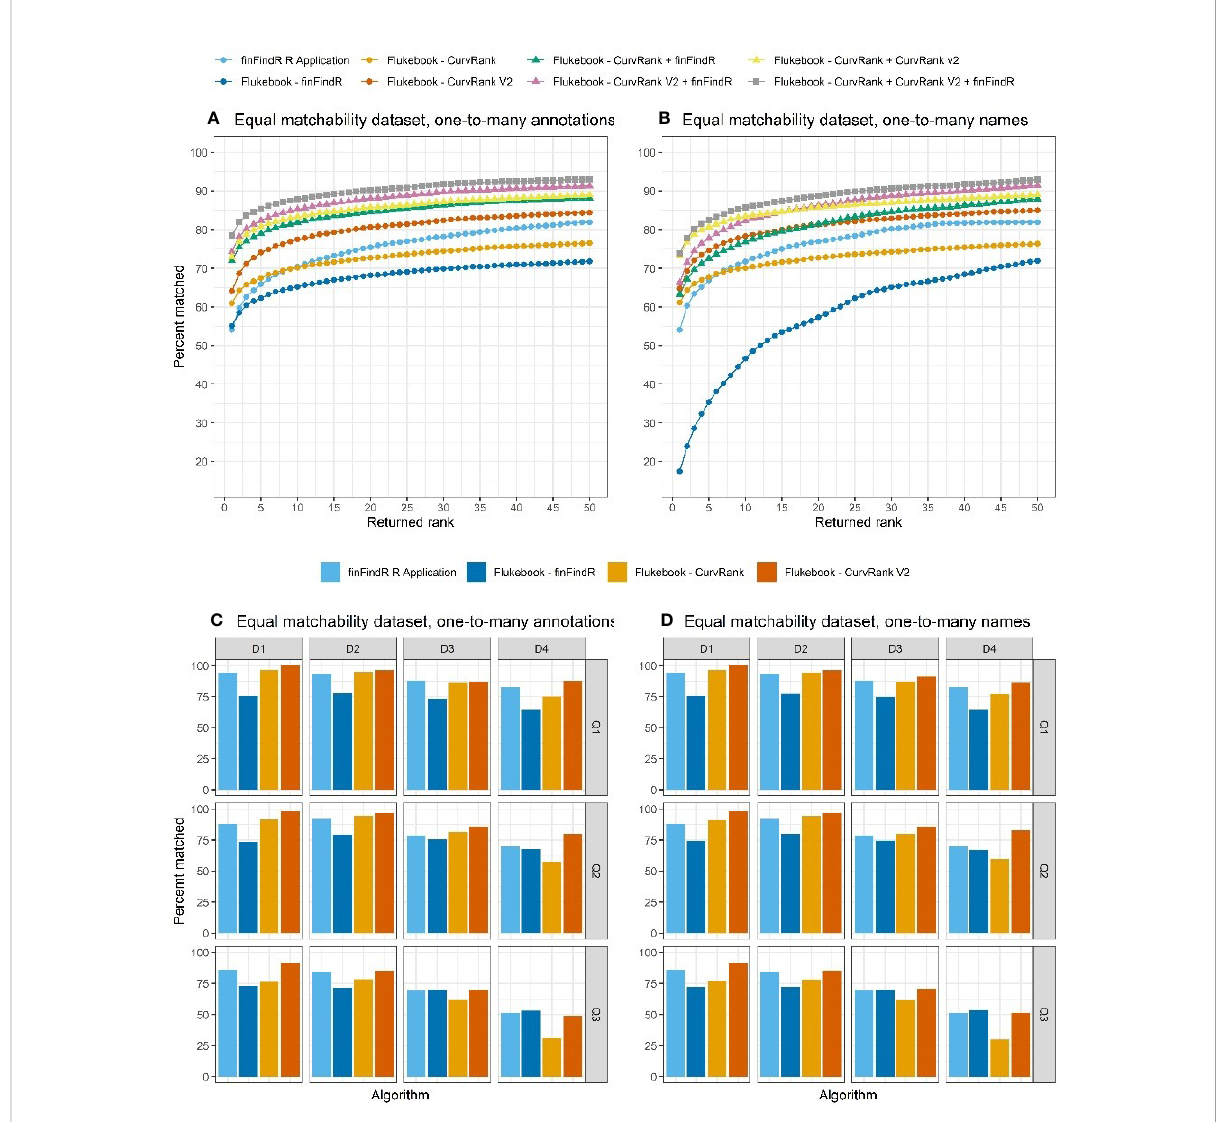
FIGURE 7 The percentage of images correctly matched by each algorithm and combination of algorithms (Flukebook algorithms only) and their cumulative rank position for the equal matchability tests in the (A) one-to-many annotations comparisons and (B) the one-to-many names comparisons; as well as the percentage of images of varying image quality and fi n distinctiveness correctly matched by the independent algorithms for the equal matchability tests in the (C) one-to-many annotations comparisons and (D) the one-to-many names comparisons. For reference, Q1 = excellent quality image, Q2 = average quality image, Q3 = poor quality image, D1 = very distinctive fi n, D2 = average amount of distinctive features on fi n, D3 = low distinctiveness, and D4 = not distinct fi n (Urian et al., 1999;Urian et al.